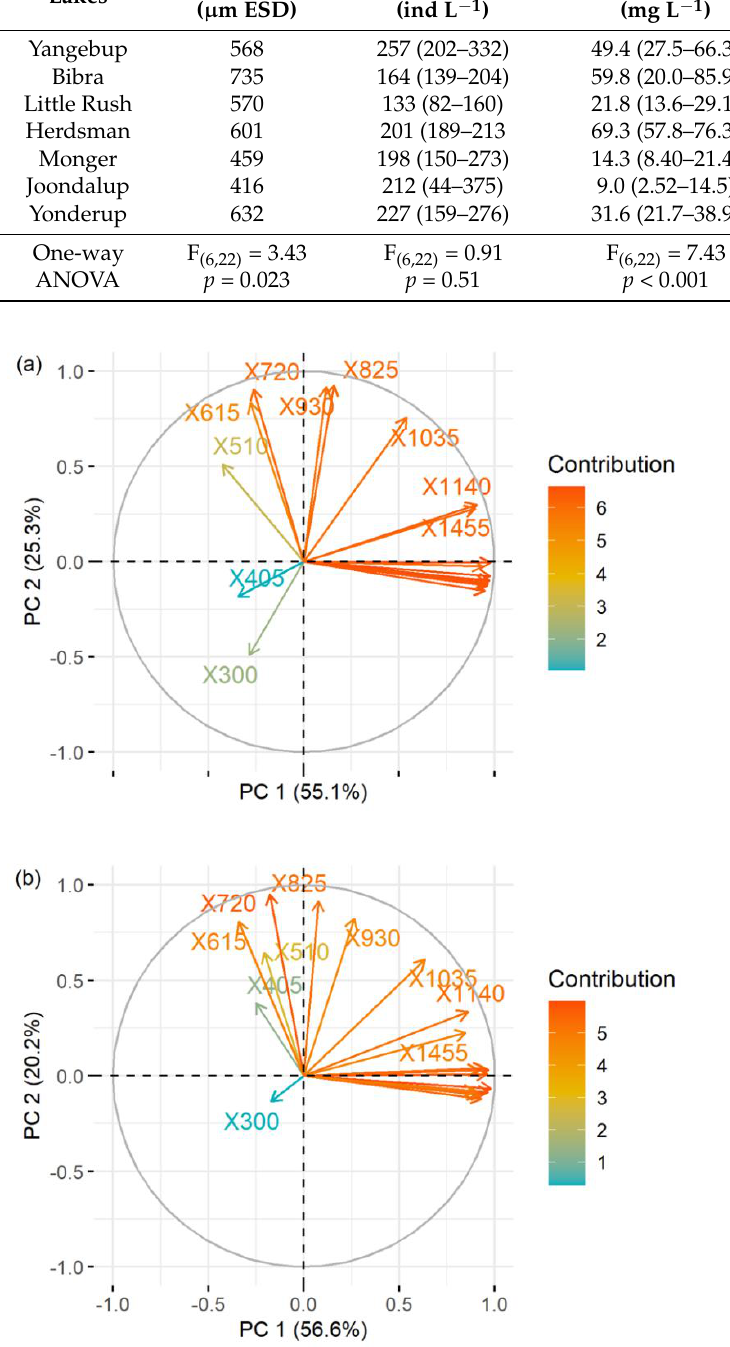
Figure 4. Biplots for the principal component analysis (PCA) based on zooplankton ( a ) biomass and ( b ) density in 105 µm equivalent spherical diameter (ESD), where arrows represent zooplankton biomass or density in each 105 µm bin. The colour scale of the arrows represents the strength of the contribution. For example, 300 represents the density of zooplankton from 300 – 404 µm ESD size fraction, while 405 represents density of zooplankton from the 405 – 509 µm ESD range. All data were log 10 (1+x) transformed.